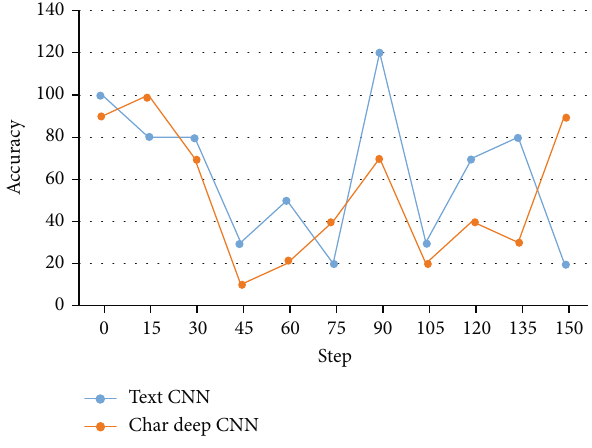
Figure 6: PPL change curve during training.